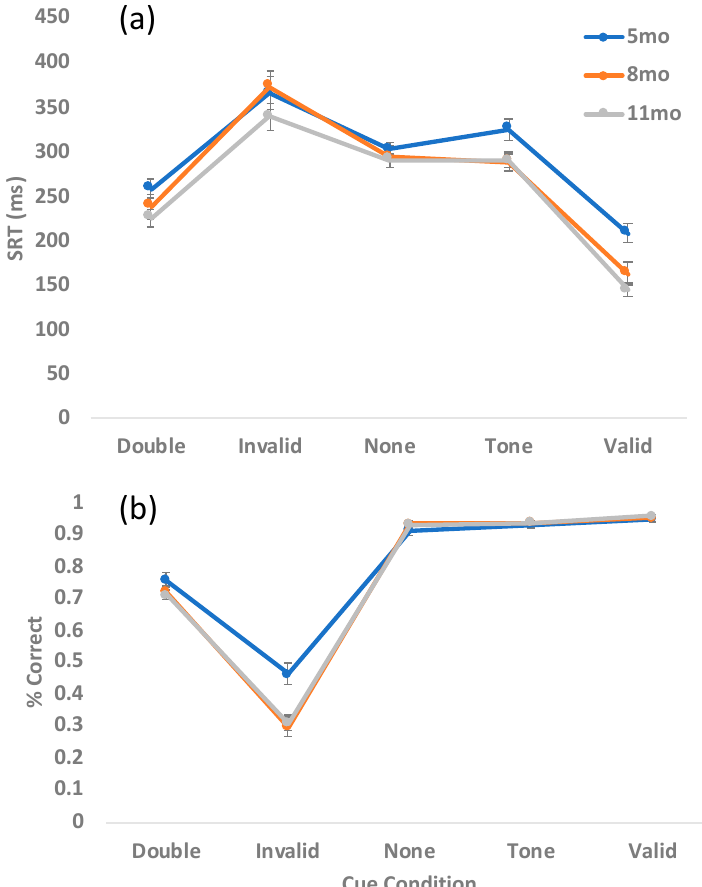
Figure 2. Raw saccadic reaction time (SRT) data ( a ) and percent correct ( b ) by age. Error bars represent +/ − SEM.